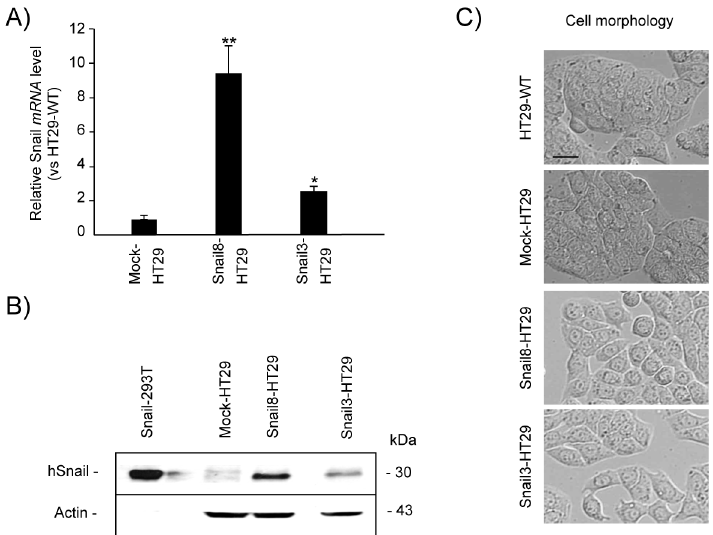
Fig 2. Characterization of Snail-HT29 stable clones. Quantitative RT-PCR analysis of human SNAIL mRNA levels normalized to the expression of SNAIL in HT29-WT. Mean ± SEM, n = 8, * p < 0.02; ** p < 0.01 (B) Western blot analysis of Snail in mock-HT29 and in Snail overexpressing HT29 cells (clones Snail8-HT29- high expression of Snail and Snail3-HT29 – low expression of Snail). (C) Morphology of HT29-WT, mock- HT29 and Snail-overexpressing HT29 cells as observed by phase contrast microscopy (scale bar, 10 μ m).